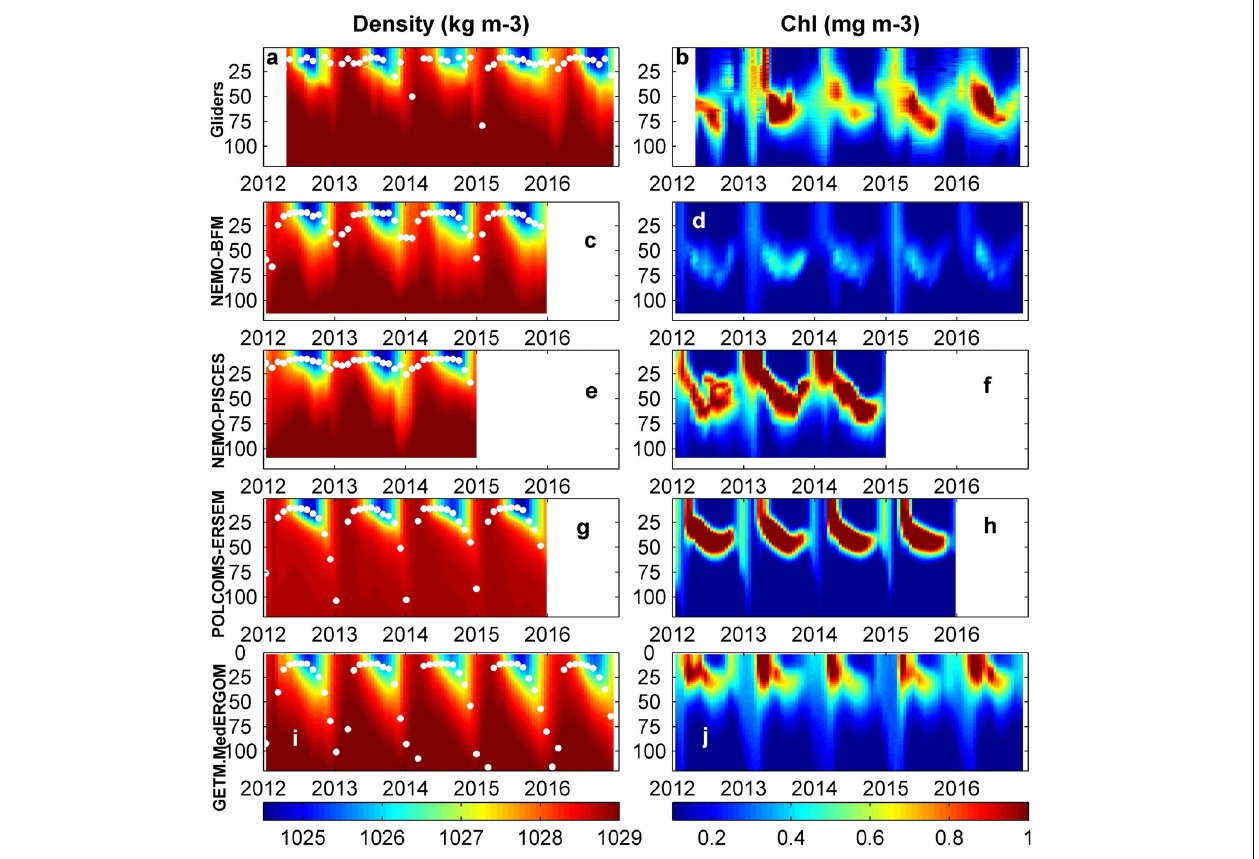
FIGURE 8 | z–t plots of water density and chlorophyll- a at the Ibiza Channel from gliders and models. White dots are mixed-layer depth estimates. Gliders (a–b) , NEMO-BFM (c–d) , NEMO-PISCES (e–f) , POLCOMS-ERSEM (g–h) , and GETM-MedERGOM (i–j)